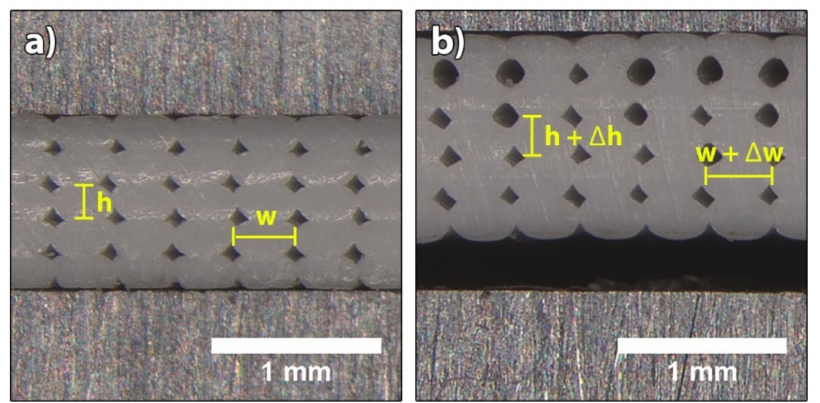
Figure 16. Images of the cross-section of a 3D printed sample for determination of height (h) and width (w) of deposited filaments: ( a ) no exposure, ( b ) after transformation at 90 ◦ C.